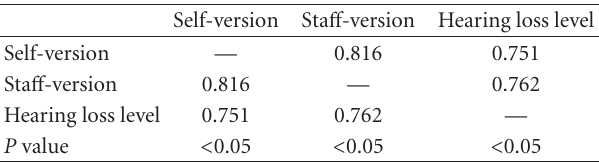
Table 4: Pearson’s correlation coe ffi cient results ( r ) in NHHI results with audiological